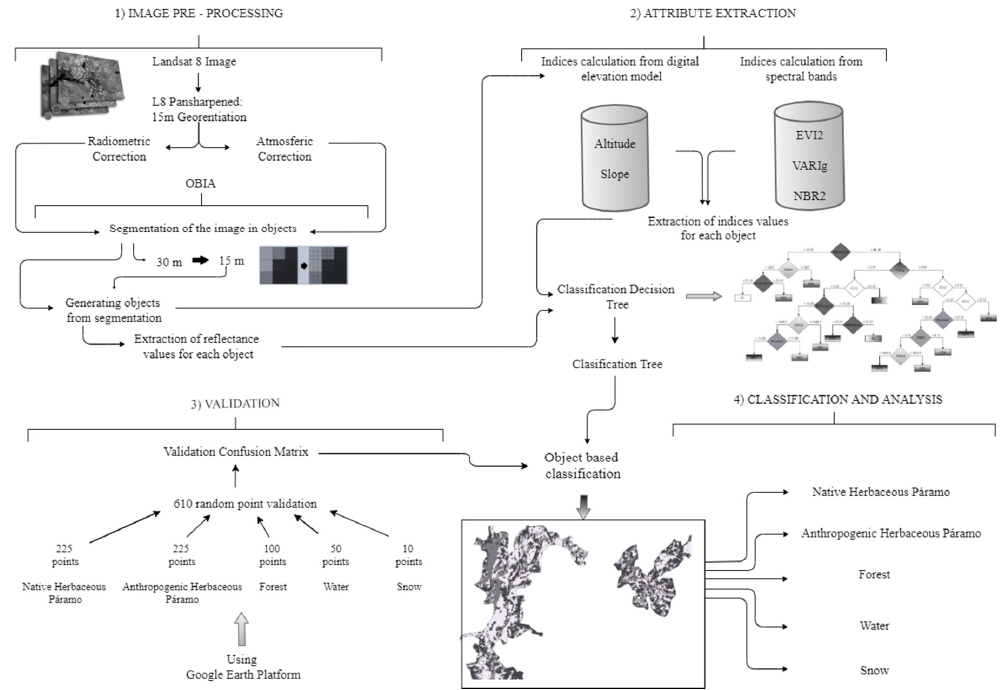
Figure 2. Workflow and methodology of land use and land cover classification.